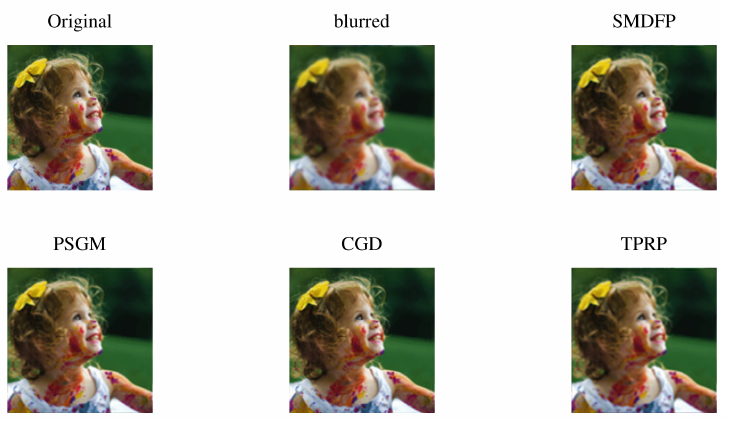
Figure 4. Comparison of the original image, blurred image, SMDFP image, CGD image, PSGM image, and TPRP image for the number of iterations, CPU time, MSE, and